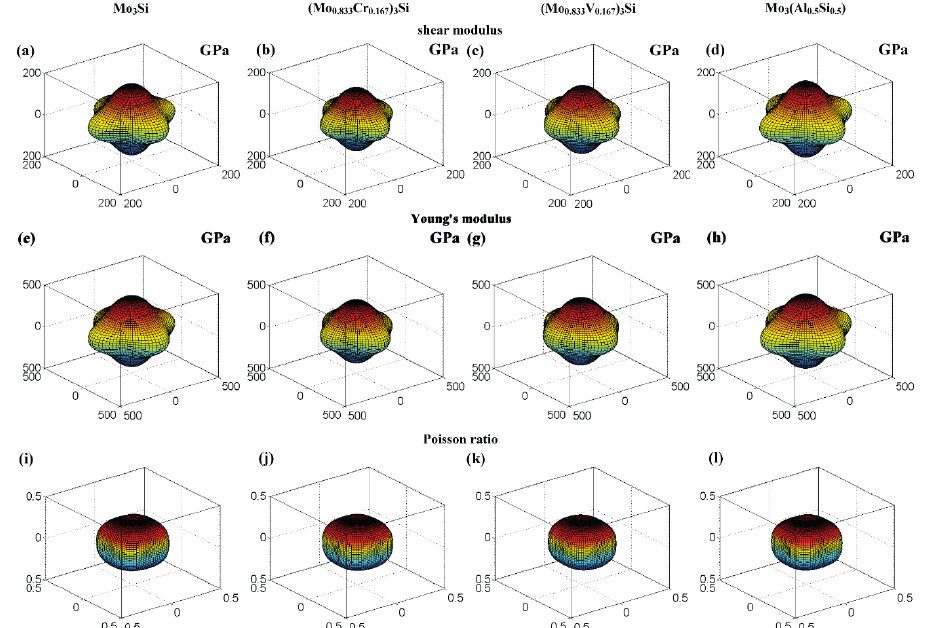
Figure 6. Three-dimensional contours of the shear modulus, Young’s modulus and Poisson ratio for undoped and doped Mo 3 Si. The distance between zero and any point on the surfaces is equal to the elastic modulus or Poisson ratio in that direction. ( a – d ) Shear modulus; ( e – h ) Young’s modulus; ( i – l ) Poisson ratio. Metals 2021 , 11 , x FOR PEER REVIEW